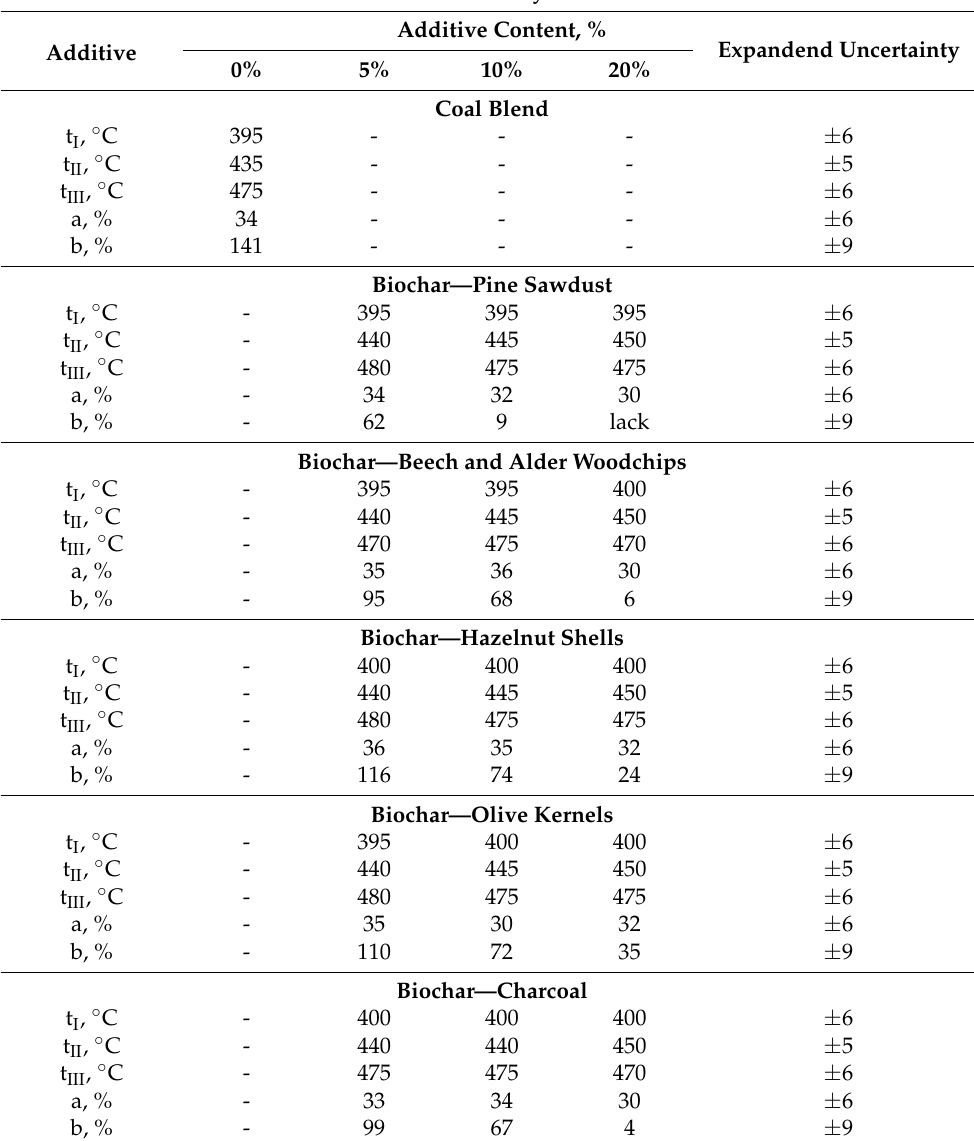
Table A5. Influence of carbonized biomass supplementation on dilatometric properties by Arnu– Audibet method.